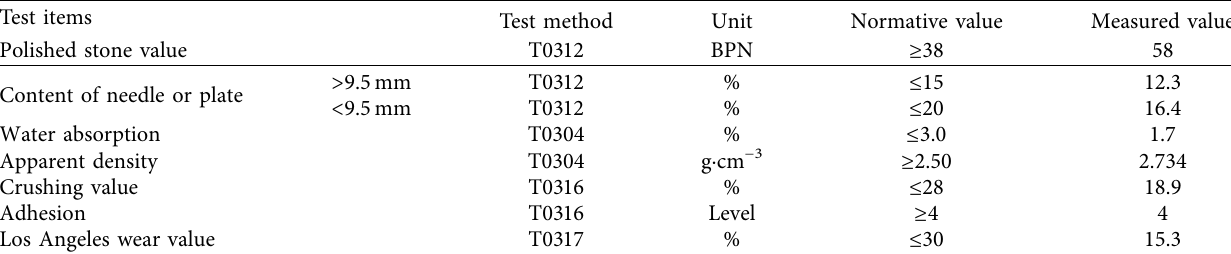
Table 1: Properties of coarse aggregate.